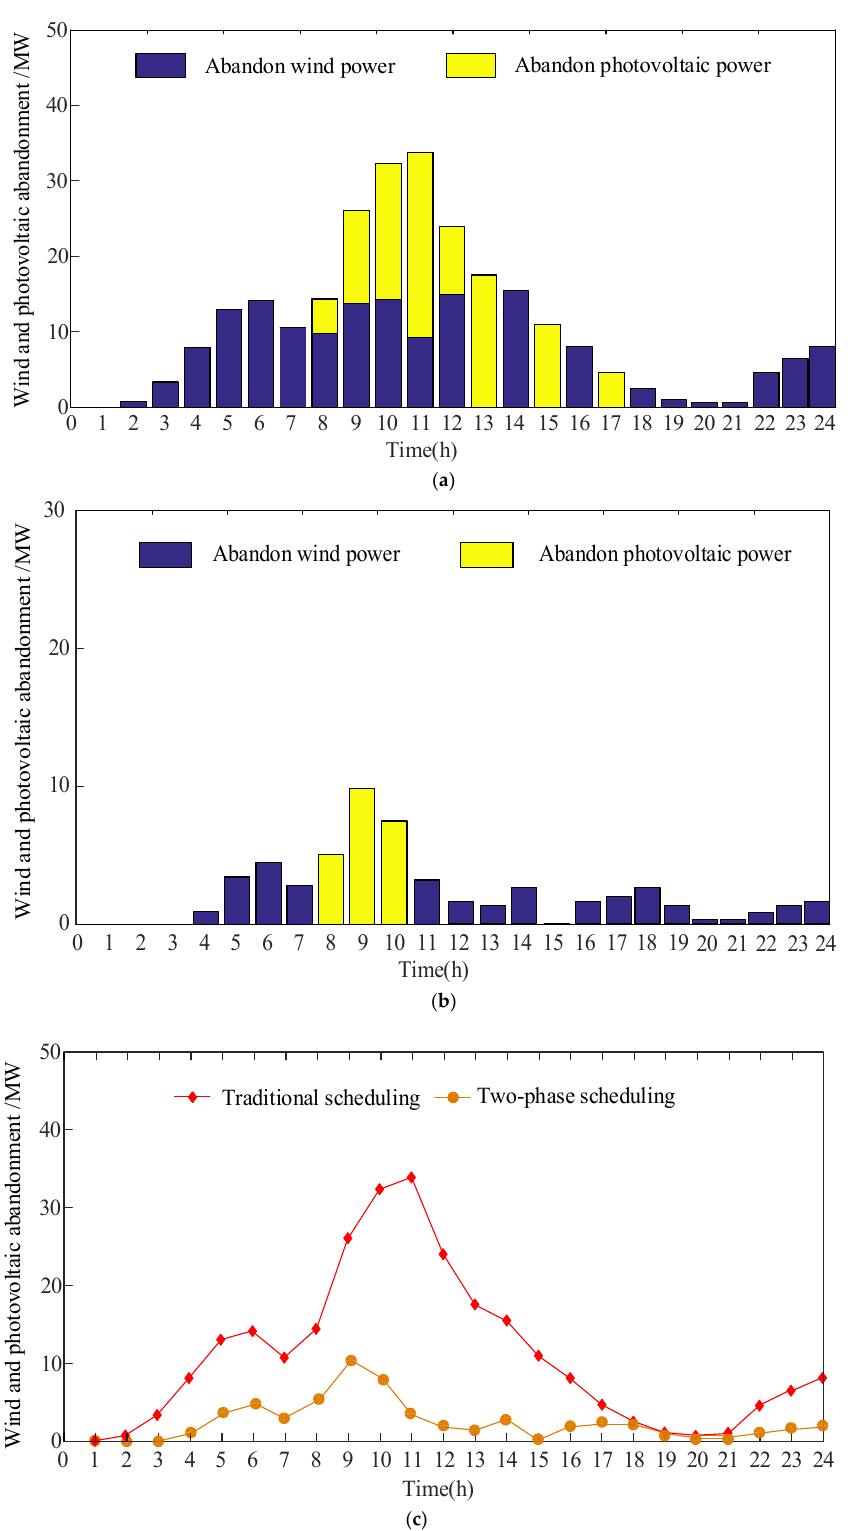
Figure 8. Wind and photovoltaic abandonment. ( a ) Wind and photovoltaic curtailment power under Traditional scheduling, ( b ) Wind and photovoltaic abandonment under Two‑phase scheduling, ( c ) The comparison of Wind and photovoltaic abandonment in Traditional scheduling and Two-phase scheduling. Figure 8 is the wind and photovoltaic abandonment. (a) is the amount of wind and light curtailment under the traditional scheduling. The wind curtailment is mainly con- centrated at 03:00 to 12:00, and the light curtailment is concentrated in 08:00 to 13:00 and 15:00. Under this traditional model, the amount of wind and light curtailment is more; (b) is for the two-stage scheduling, the amount of wind and light abandonment is mainly concentrated in 04:00 to 07:00 and 11:00, and the curtailment of light is concentrated in 08:00 to 10:00, the amount of curtailment of wind and light under this two-stage model is significantly reduced, and there is no curtailment of wind and light at other times; (c) is for the comparison of the amount of wind and light curtailment under the traditional scheduling and the two-stage scheduling. It can be seen that the model proposed in this paper significantly improves the problem of excessive wind and light curtailment under traditional scheduling, provides a basis for joint optimization scheduling, and has certain practical significance. 4.2.6. Comparison between Relative Error and Absolute Error Figure 9 shows the comparison of relative error and absolute error, and the two errors reached the maximum at 11:00, 30.12 MW and 7.51%, respectively. The relative error is mainly below 8%, which further illustrates the superiority of the proposed model.